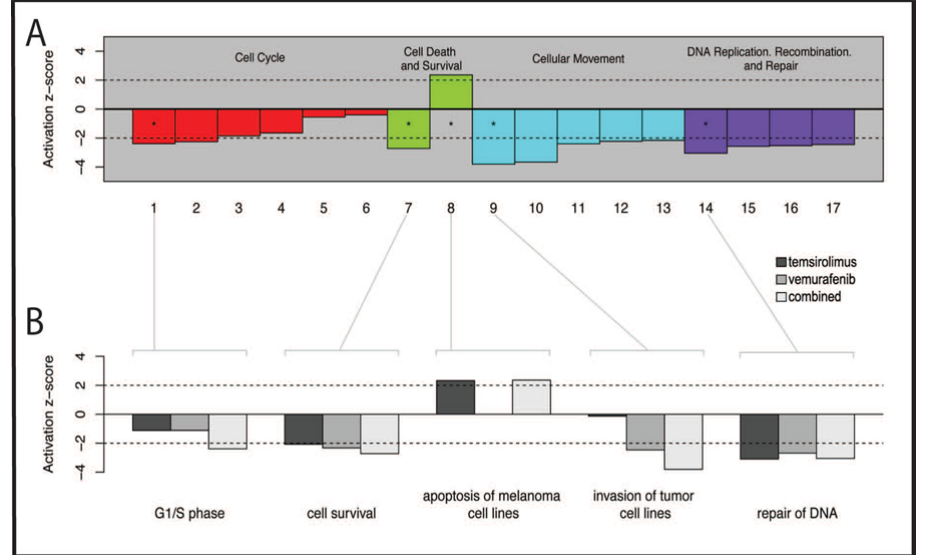
Figure 7. Ingenuity function analysis. ( A ) Bar plot of the activation z -scores of selected downstream functions in combination treated samples (5 µM vemurafenib and 5 µM temsirolimus) compared to untreated cells. Functions with z -scores greater than two are predicted as being “activated” in this comparison, while those with scores less than − 2 are “inhibited”. All columns were statistically significant; p < 0.005. Column numbers correspond to the list of downstream functions shown in Table 3; and ( B ) A detailed presentation of bar plots of activation z -scores, showing the most activated downstream functions for each of the three treatments; 25 µM temsirolimus vs . untreated cells, 15 µM vemurafenib vs. untreated cells or 5 µM vemurafenib + 5 µM temsirolimus vs. untreated cells. All columns were statistically significant; p <